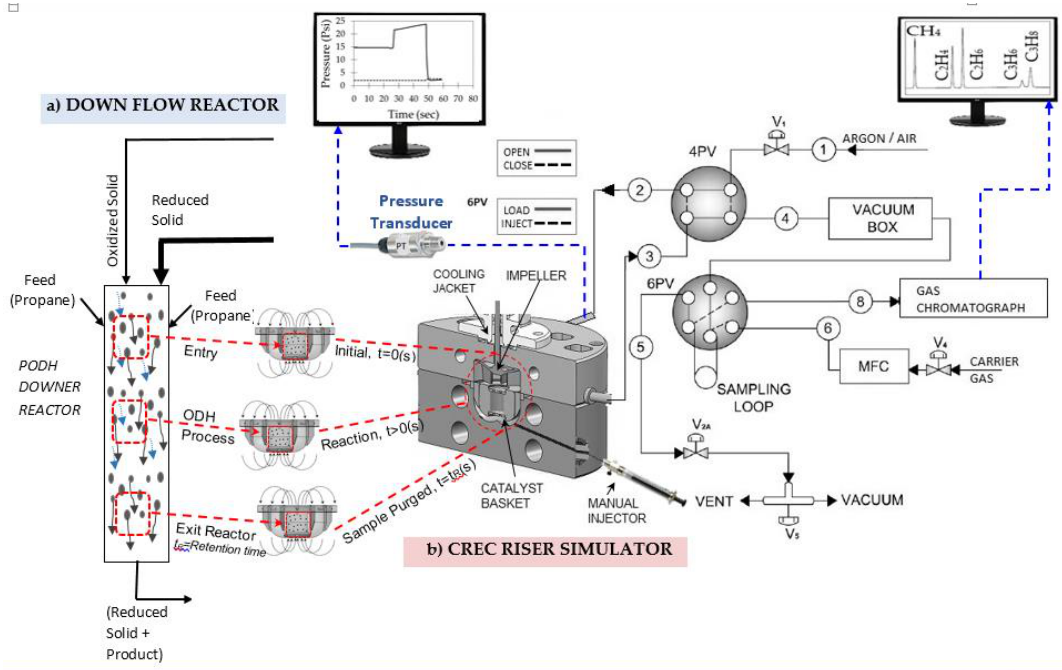
Figure 3. Schematic Diagram Describing: ( a ) A propane oxidative dehydrogenation